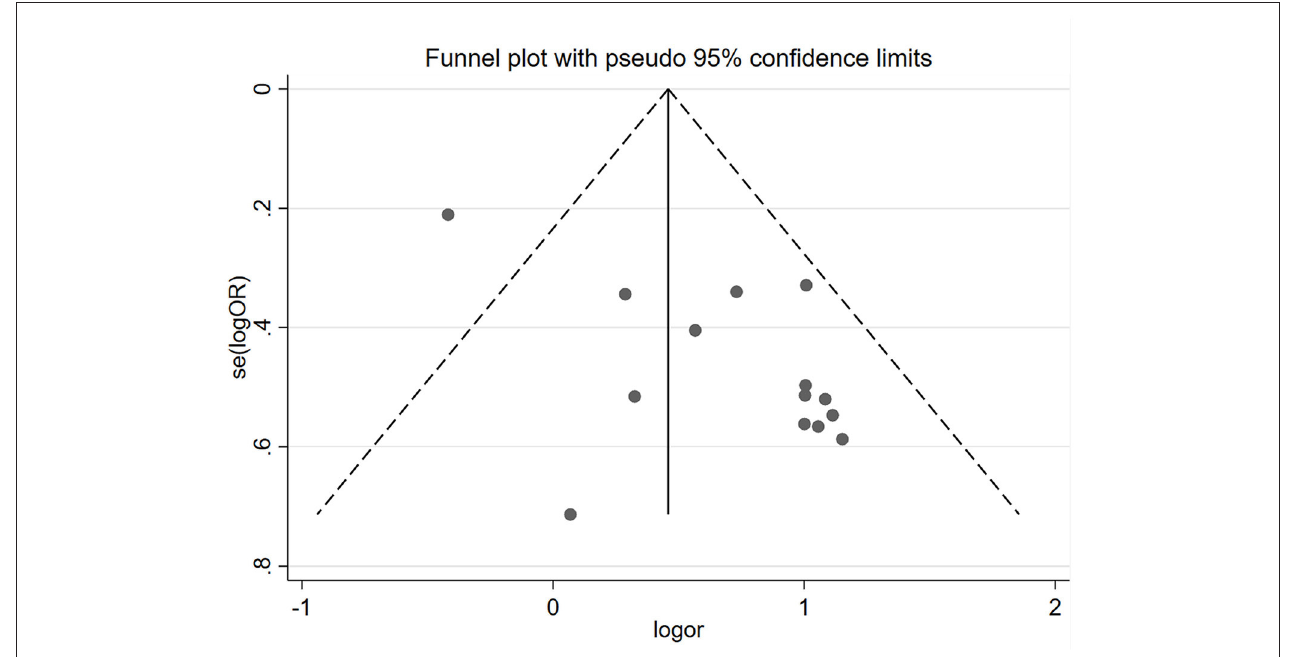
FIGURE 12 | Funnel plot of trials meeting inclusion criteria (CPR). The Egger’test P =